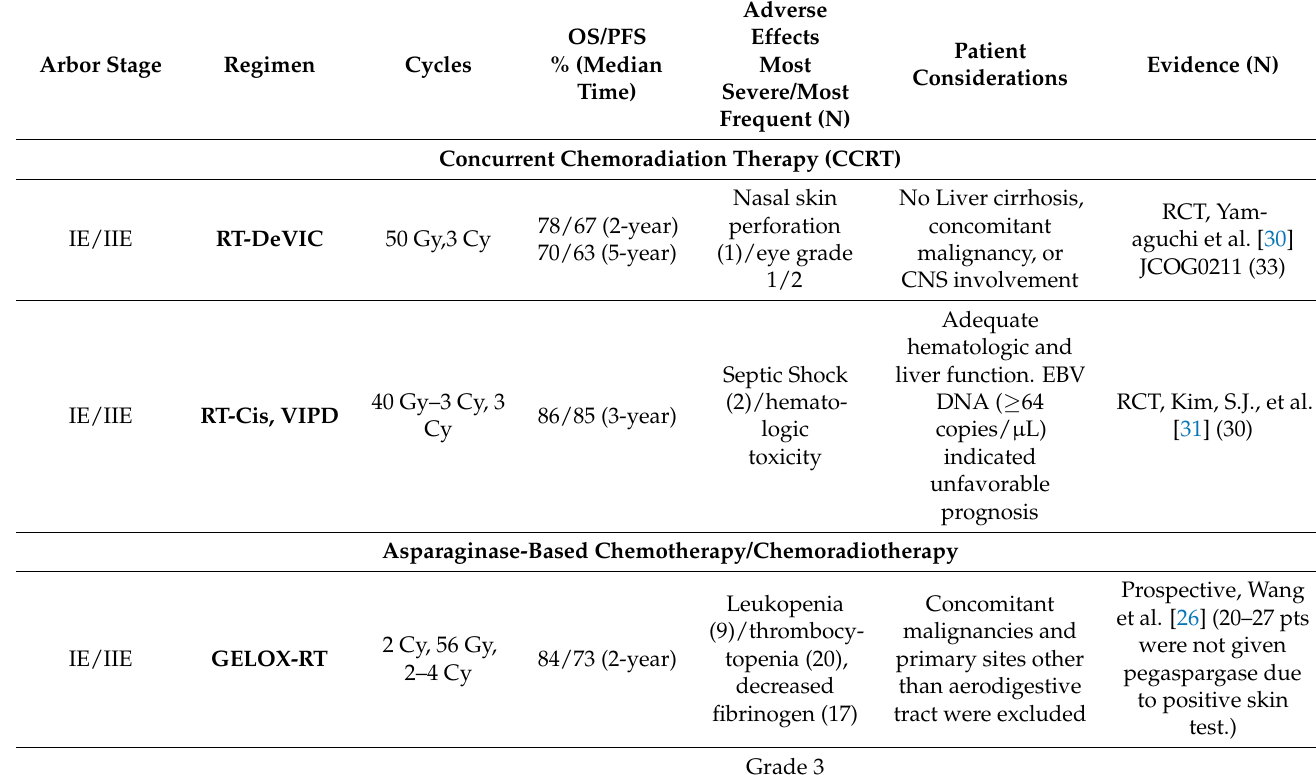
Table 1. Current standard of care therapies for